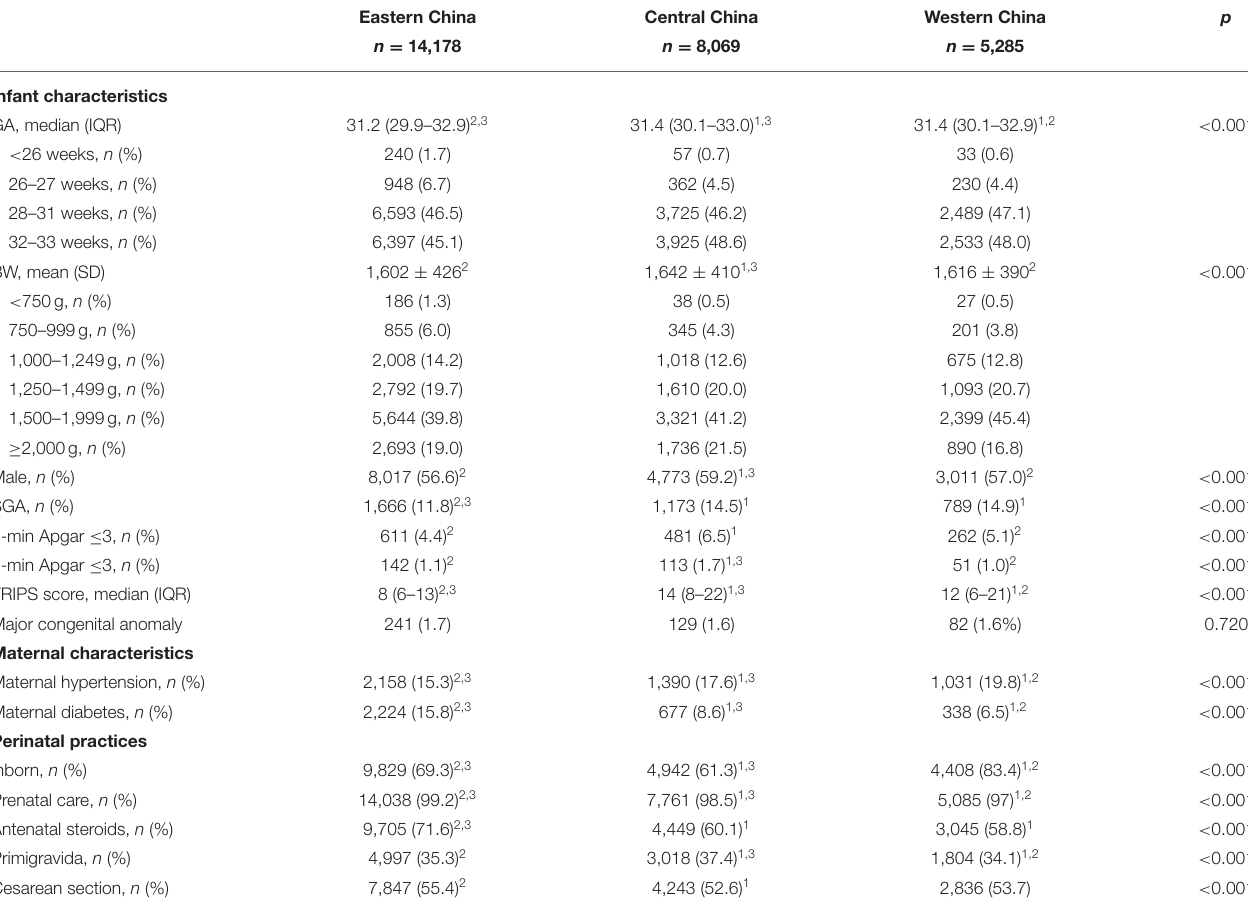
TABLE 1 | Characteristics of the infants and maternal admitted to NICUs in three regions of China during